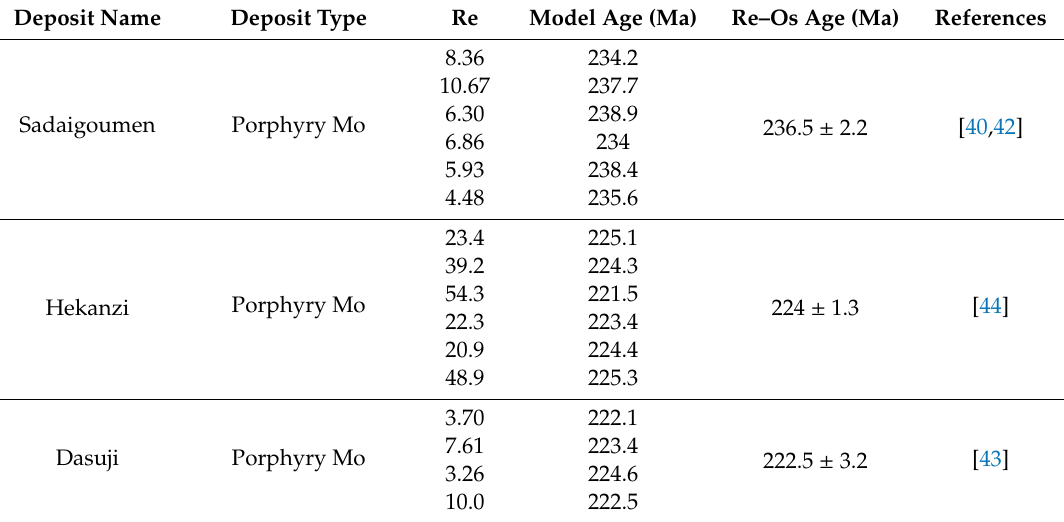
Figure 9. The data of Re concentrations of molybdenite in the Yan-Liao metallogenic belt, North China Craton. ( A ) The concentrations of Re vs. ages of molydenite diagram of the Yan-Liao metallogenic belt, North China Craton. An obvious increasing trend from Triassic to Yanshanian Period (Jurassic and Cretaceous) is observed. ( B ) The distribution of Mo deposits and their Re concentrations in molybdenite from the Yan-Liao metallogenic belt, North China Craton. The meanings of the numbers denoted in the diagram are the same as Figure 1. Table 4. Summary of Re contents and model ages of molybdenite from the Late Mesozoic Mo deposits in the Yan-Liao metallogenic belt, North China